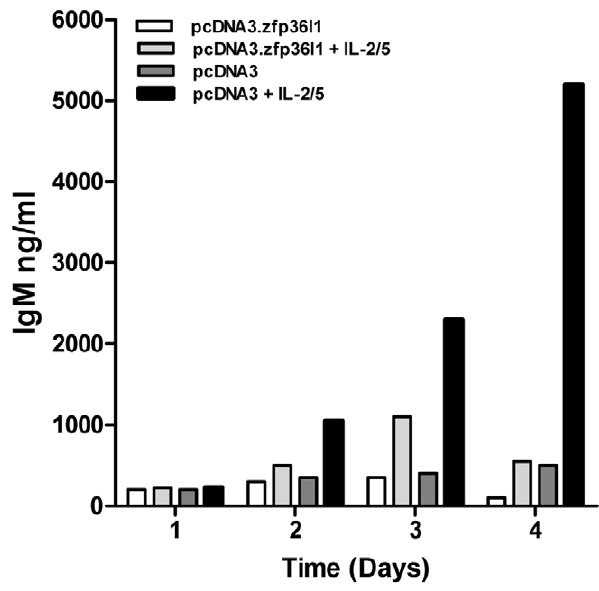
Figure 3. Ectopic expression of ZFP36L1 in BCL1 cells inhibits cytokine-induced. IgM production. Levels of IgM production in ZFP36L1 transfected BCL1 stimulated with IL-2/5 (20 ng/ml IL-2 and 5 ng/ml IL-5) over 4 days compared to levels produced by empty vector BCL1 cells cultured under the same conditions. Cells were co- transfected with either pcDNA3.ZFP36L1 or empty pcDNA3 vector and pcDNA3.EGFP and then sorted on the basis of EGFP expression before been set up in culture in the absence or presence of cytokines. Cells were cultured at 4.0 6 10 4 /ml and ELISA measurements were made in duplicate. The results shown are representative of 3 similar experiments.